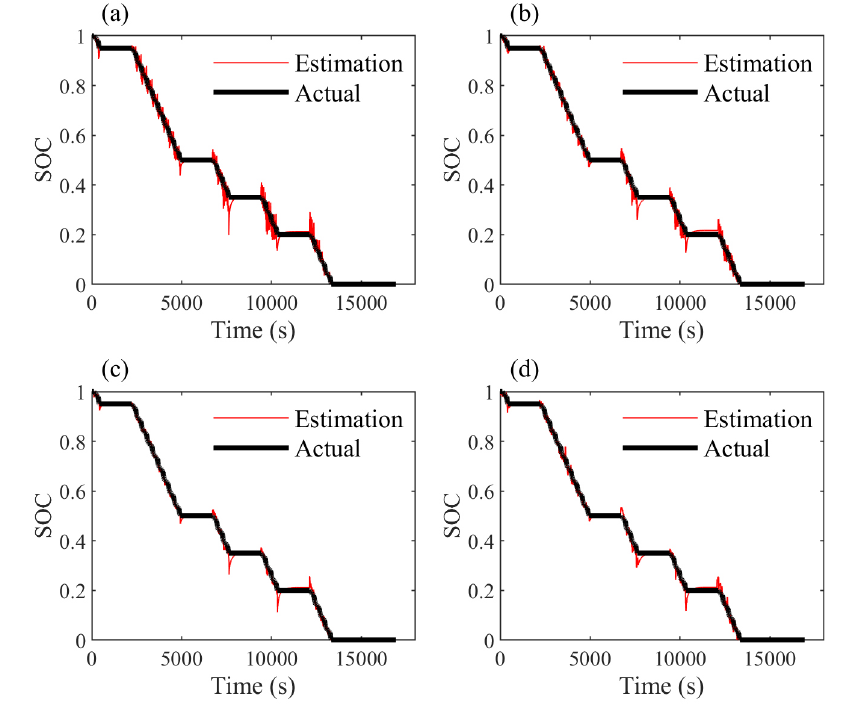
Figure 16. SOC estimation results for the DST profile in the four modes (using RBF): ( a ) first mode, ( b ) second mode, ( c ) third mode, and ( d ) fourth